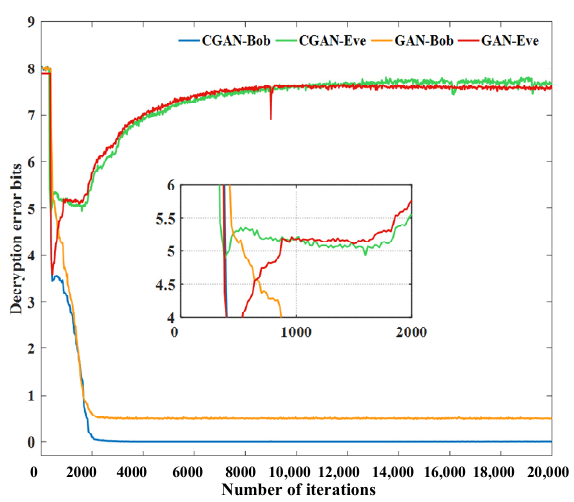
Figure 11. Comparison of training results in 16-bit scenarios.